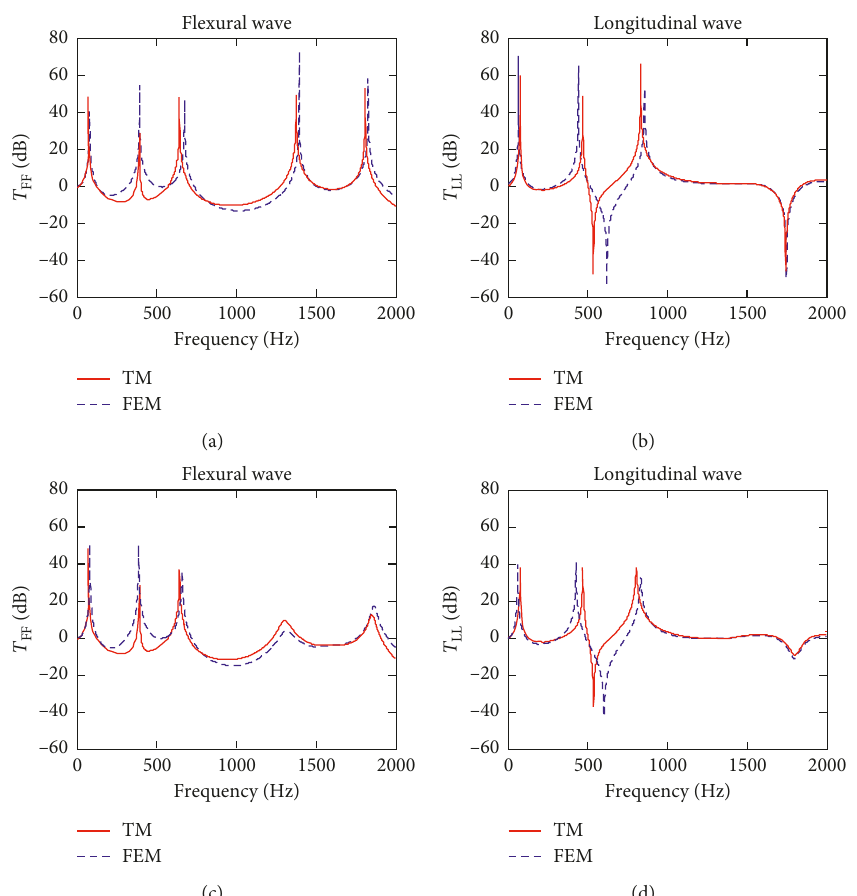
Figure 9: Comparison between TM method and FEM. (a, b) Vibration transmissibility of flexural and longitudinal waves with open circuits. (c, d) Vibration transmissibility of flexural and longitudinal waves with closed circuits, where L � 0.4 H and R � 800 Ω